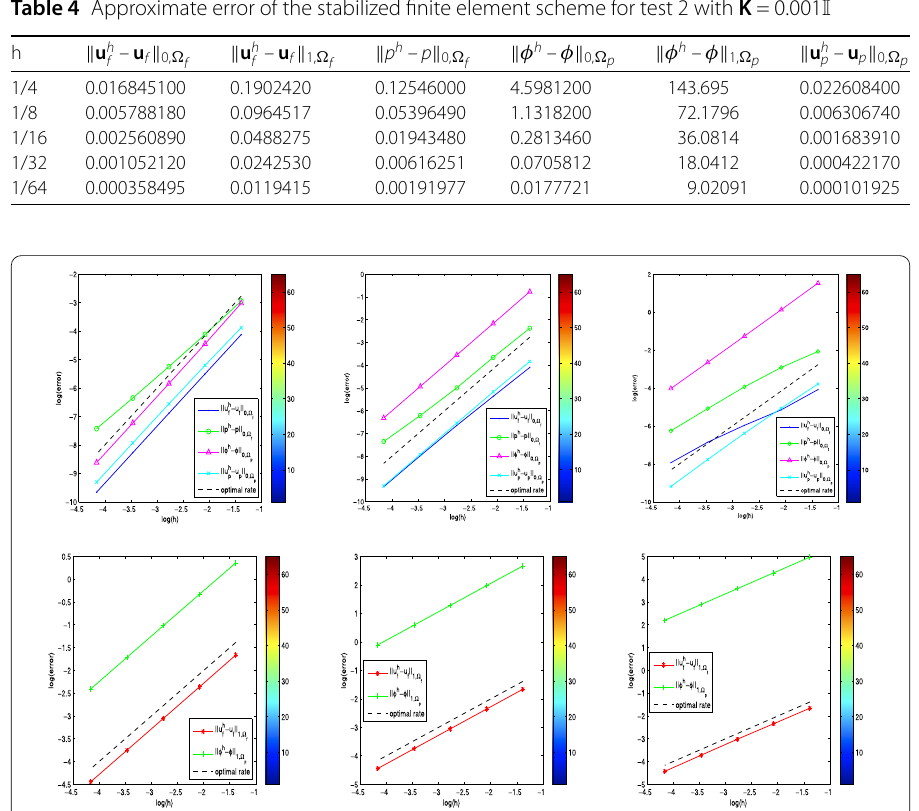
including optimal error estimates, was derived for the proposed algorithm. To show